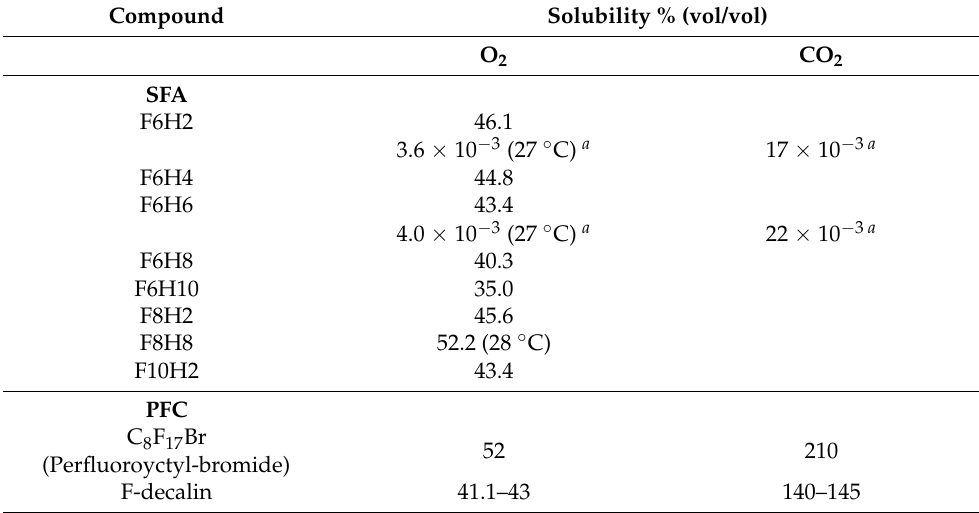
Table 2. Oxygen (O 2 ) and carbon dioxide (CO 2 ) solubilities of selected SFA and PFC adapted from Krafft and Meinert [8,24]; a from molecular simulations, given in molar